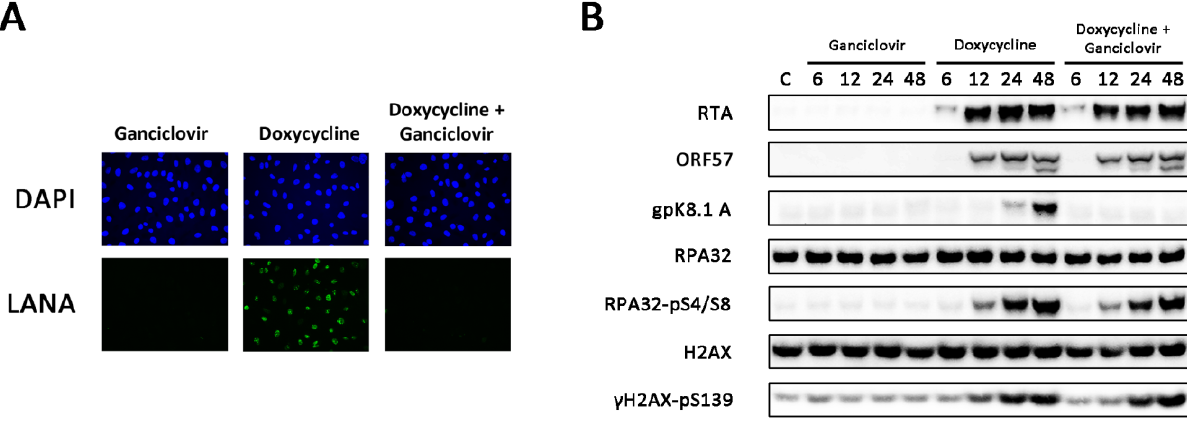
Figure 2. DDR activation following inhibition of viral DNA synthesis and late viral gene expression. ( A ) Immunofluorescence microscopy analysis of LANA expression in EA.hy926 cells following infection with supernatants obtained from TRE-BCBL-1-RTA cells collected 48 h after treatment with 100 μM ganciclovir alone, 0.5 μg/mL doxycycline alone or both compounds in combination; ( B ) Phosphorylation of RPA32 and H2AX in TRE-BCBL-1-RTA cells treated with 100 μM ganciclovir alone, 0.5 μg/mL doxycycline alone or both compounds in combination.